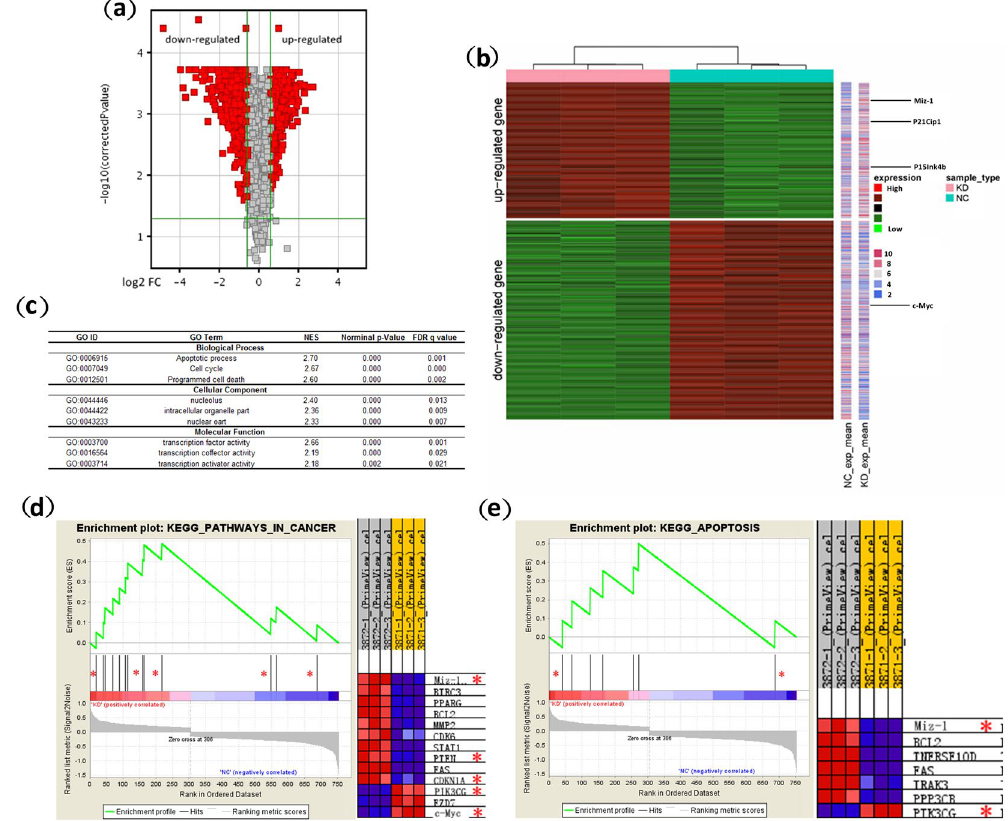
Figure 2. Global gene expression profiles and GSEA analysis. A DNA microarray analysis was performed using three RPL23-KD DNA samples and three NC DNA samples of infected SKM-1 cells. ( a ) A volcano plot of all assayed probes shows the distribution of DEGs based on the expression data from RPL23-KD and NC SKM-1 samples. The X-axis is the log 2 (fold-change), and the Y-axis is the p -value on a − log 10 scale. Entities with significant differences are highlighted in red. ( b ) Unsupervised hierarchical clustering of six samples shows distinct segregation based on treatment (pink row for RPL23-KD, blue row for NC SKM-1 cells). The expression of 753 probes was significantly altered ( > 1.5-fold) in RPL23-KD cells compared with NC samples ( p < 0.05). A total of 305 probes (upper left region) were upregulated, and 448 (lower left region) were downregulated. Each row represents a gene, and each column represents a sample. The coloured bars on the right represent the absolute mean expression (absolute fold change) of each gene in the KD/NC groups. The indicated DEGs for our target molecules are shown on the right side of the bars. ( c ) Identified GO gene sets categorized by biological process, cellular component and molecular function. A GSEA analysis indicates the overrepresented pathways enriched in RPL23-KD SKM-1 cells: enrichment plots and heatmaps of leading edge genes in KEGG_ PATHWAY IN CANCER (NES = 2.09) ( d ) and KEGG_APOTOSIS (NES = 1.65) ( e ). The asterisks mark DEGs involved in Miz-1/c-Myc function and PI3K/AKT signalling. GO ID/Term: Gene Ontology ID/term; NES: normalized enrichment score; FDR: false discovery